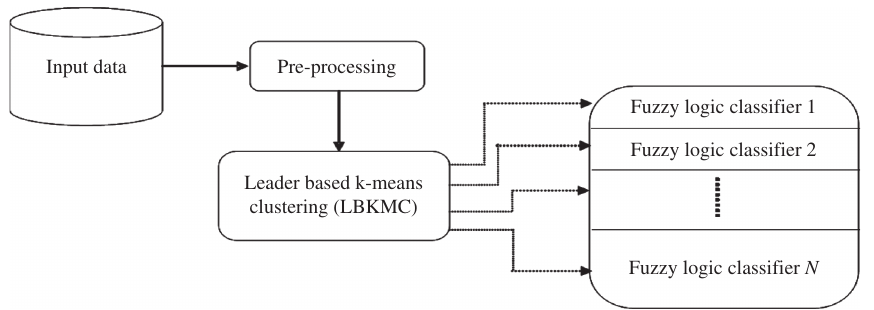
Figure 2: Cluster from the LBKMC is Trained to Apply N Number Fuzzy Logic